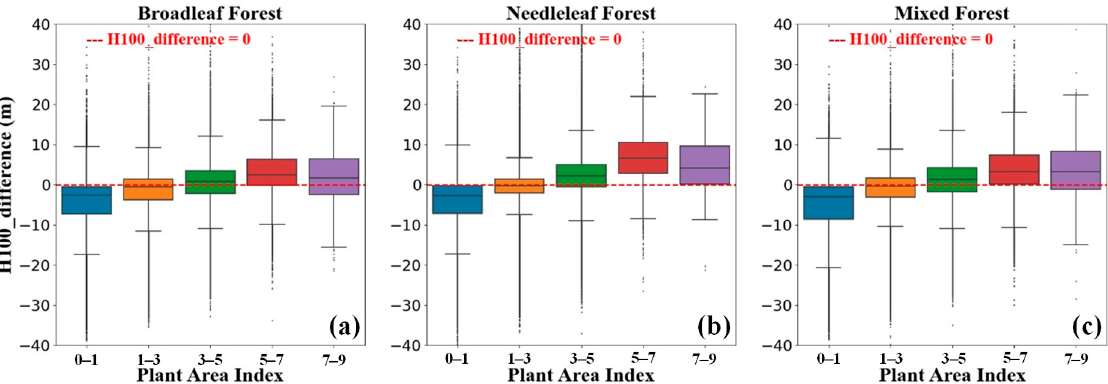
Figure 13. Boxplot of H_difference on plant area index (PAI) for ( a ) broadleaf, ( b ) needleleaf, and ( c ) mixed forest.